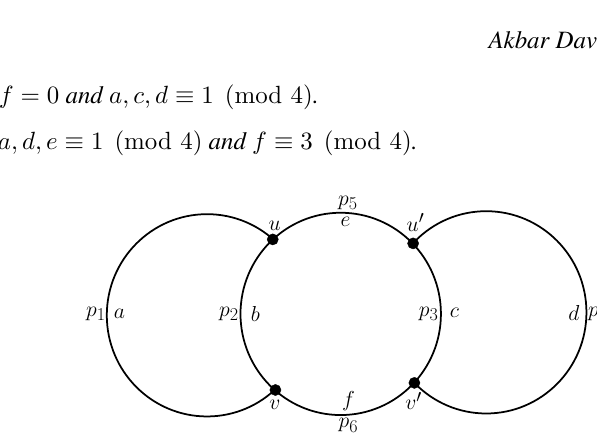
Fig. 1: A generalized polygon tree with three interior